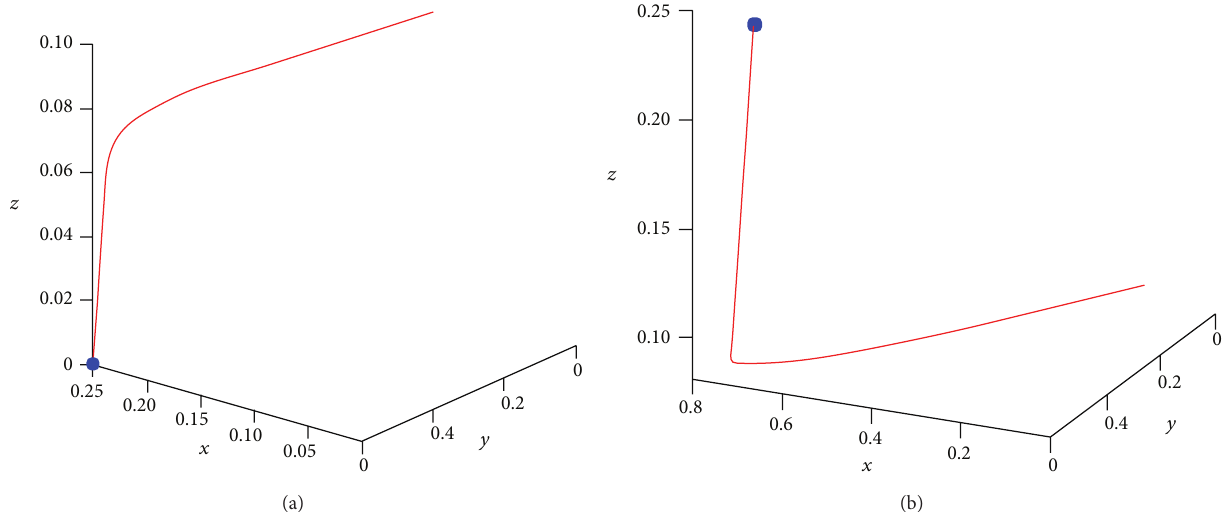
Figure 2: Phase diagram of system (1) under initial conditions (𝑥(0),𝑦(0),𝑧(0)) = (0.1, 0.1, 0.1) . (a) shows that 𝐸 1 (0.25, 0.6, 0) is locally asymptotically stable if 𝐼 1 = 0.1 mg/L; (b) shows that 𝐸 2 (0.68, 0.56, 0.28) exists and that 𝐸 2 is locally asymptotically stable if 𝐼 1 = 0.3 mg/L. The other parameters are the same as in Table 1.